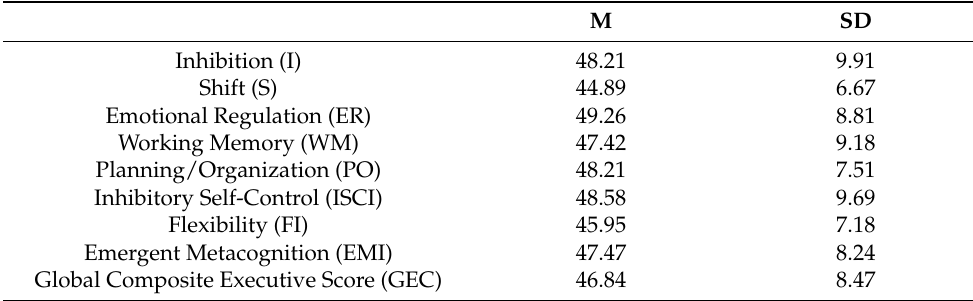
Table 1. Means and standard deviations of T scores at BRIEF-P sub-scales (n = 19) (Mean = 50, Standard Deviation =